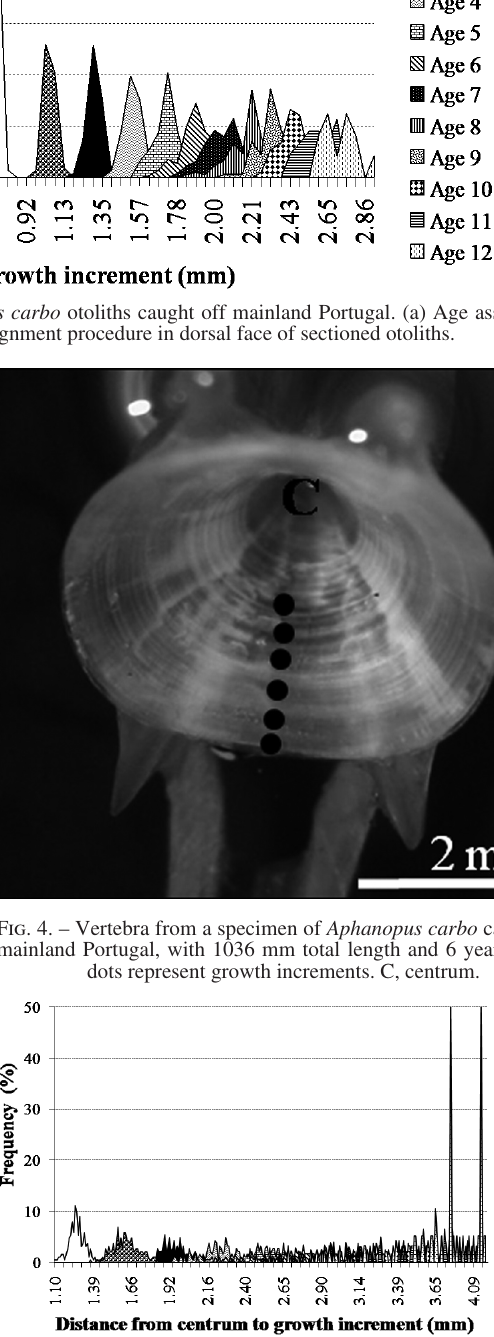
Fig . 5. – individualisation of growth increments by age from Aphanopus carbo vertebrae caught off mainland